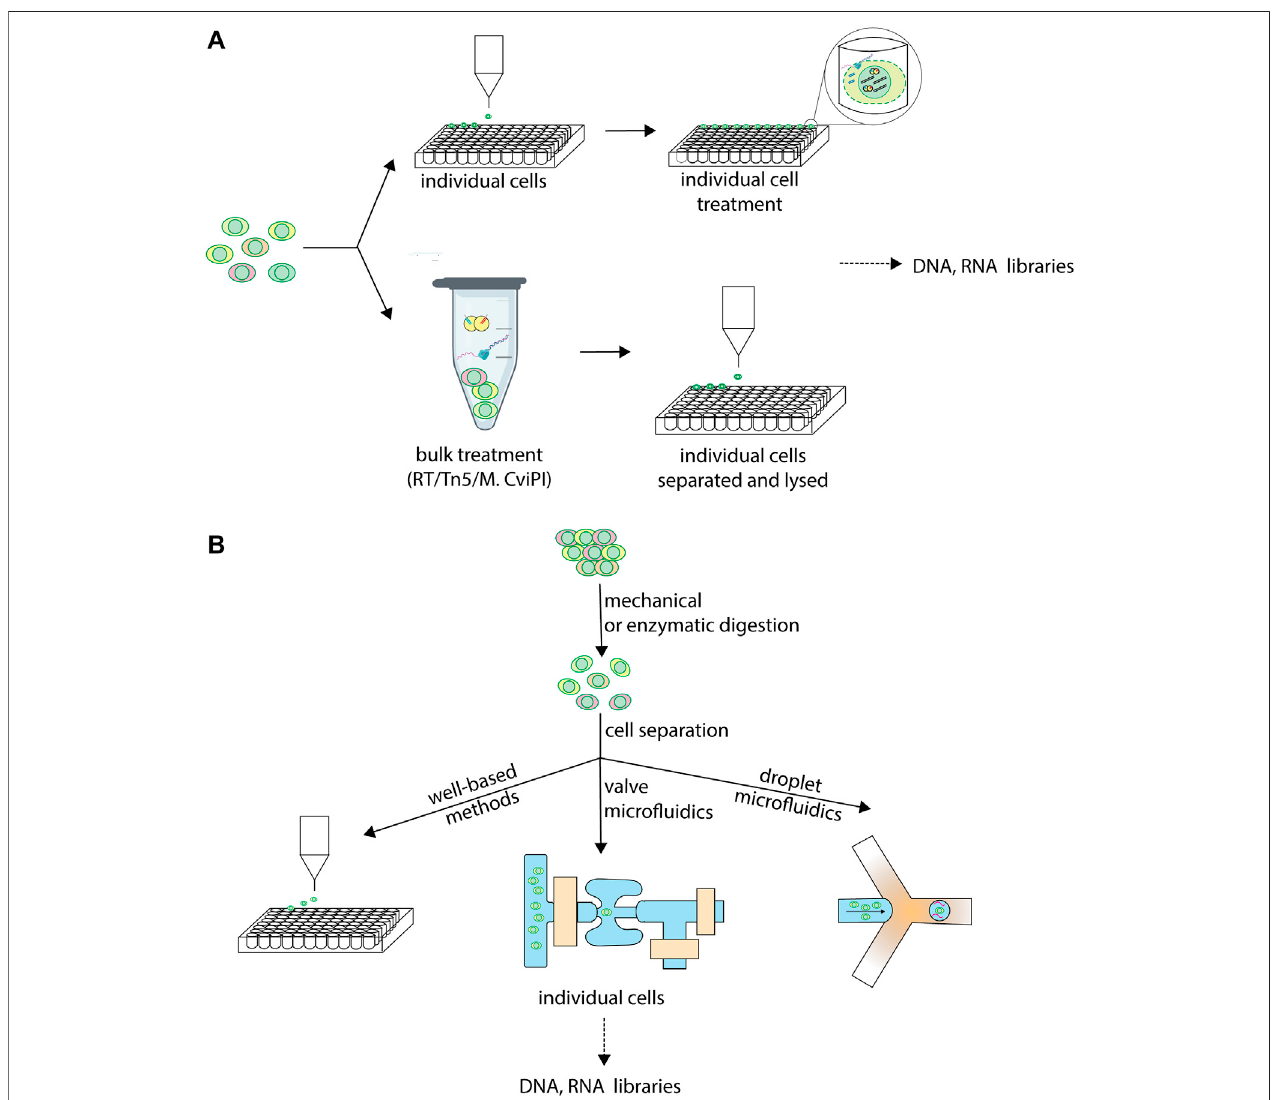
FIGURE 1 | Individual cell isolation in sc-multiomics. Single-cell multiomics techniques differ in when and how, during their work fl ow, they isolate single cells into individual reactions for further processing. (A) Differentstages at which cells are isolated in sc-multiomics. While some sc-multiomics techniques 1) startfrom the single- cell suspension by fi rst isolating individual cells (using one of the approaches in (B) and only then subject cells individually to further processing, such as enzymatic treatments (top), other techniques 2) subject the single-cell suspension to enzymatic treatment fi rst and only then isolate single cells (bottom). (B) Different technologies for isolating individual cells in sc-multiomics. Well-based methods rely on techniques such as fl uorescence-activated cell sorting (FACS) to sort individual cellsintouniquewells.Valvemicro fl uidicsmethodstreatsinglecellsindividuallyinuniquereactionwellsonmicro fl uidicchips.Dropletmicro fl uidicsencapsulateindividual cells into unique barcoded droplets for further